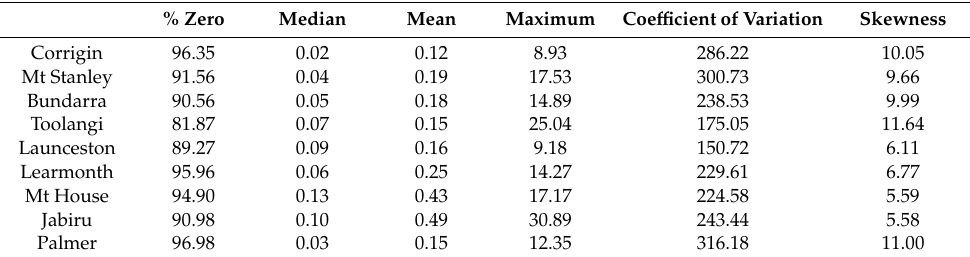
Table 1. Statistical measures of sub-daily rainfall totals for the case study stations. % Zero Mean Coe ffi cient of